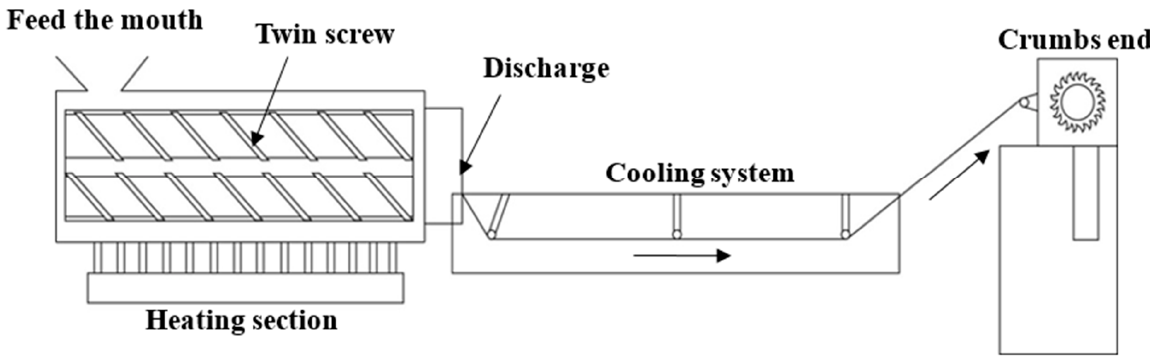
Figure 8. Twin-screw mixer processing procedure.